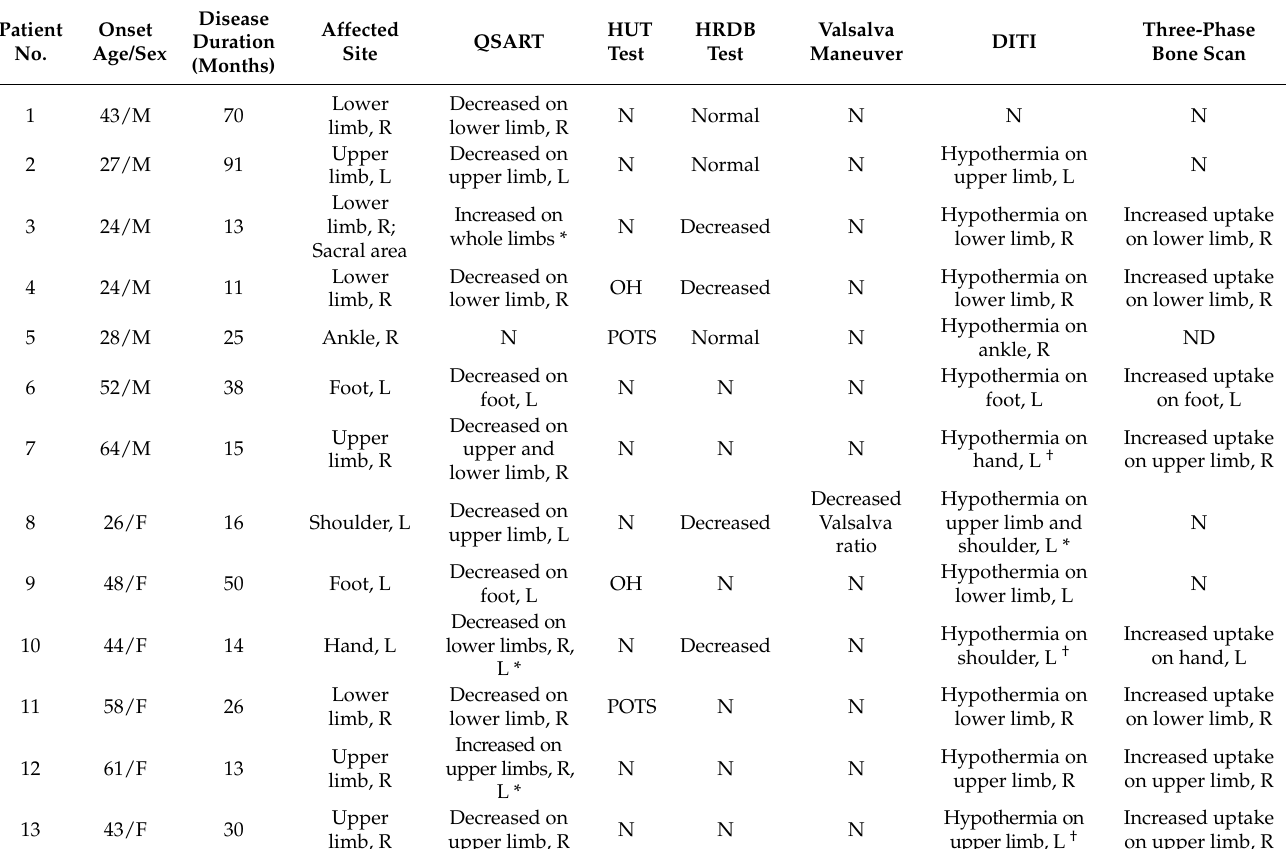
Table A2. Comparison of auxiliary tests outcome in CRPS type II patients with abnormal autonomic function screening